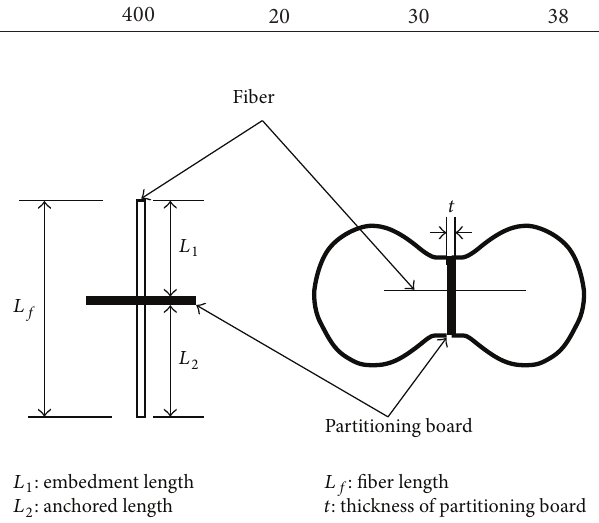
Figure 1: Arrangement of the partitioning board and fibers and setting in the